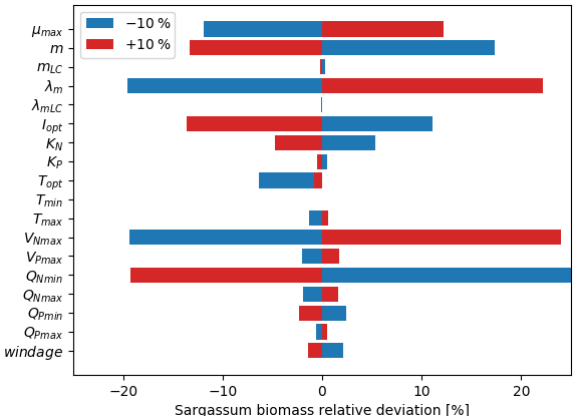
Figure 7. Sensitivity analysis to model parameters expressed as the mean relative deviation (%) between the baseline simulation and the simulation in which one parameter was modified by ± 10%. The set of parameters for the baseline simulation is given in Table